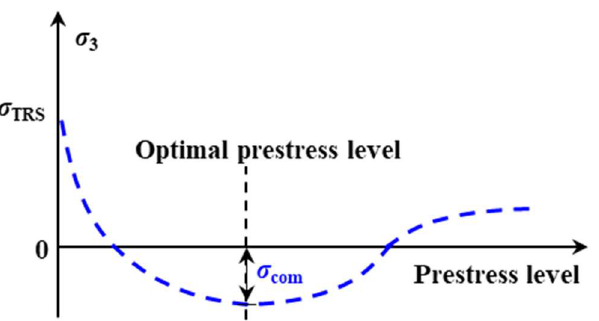
Figure 12. In-plane stress level evolution with prestress level within a composite.